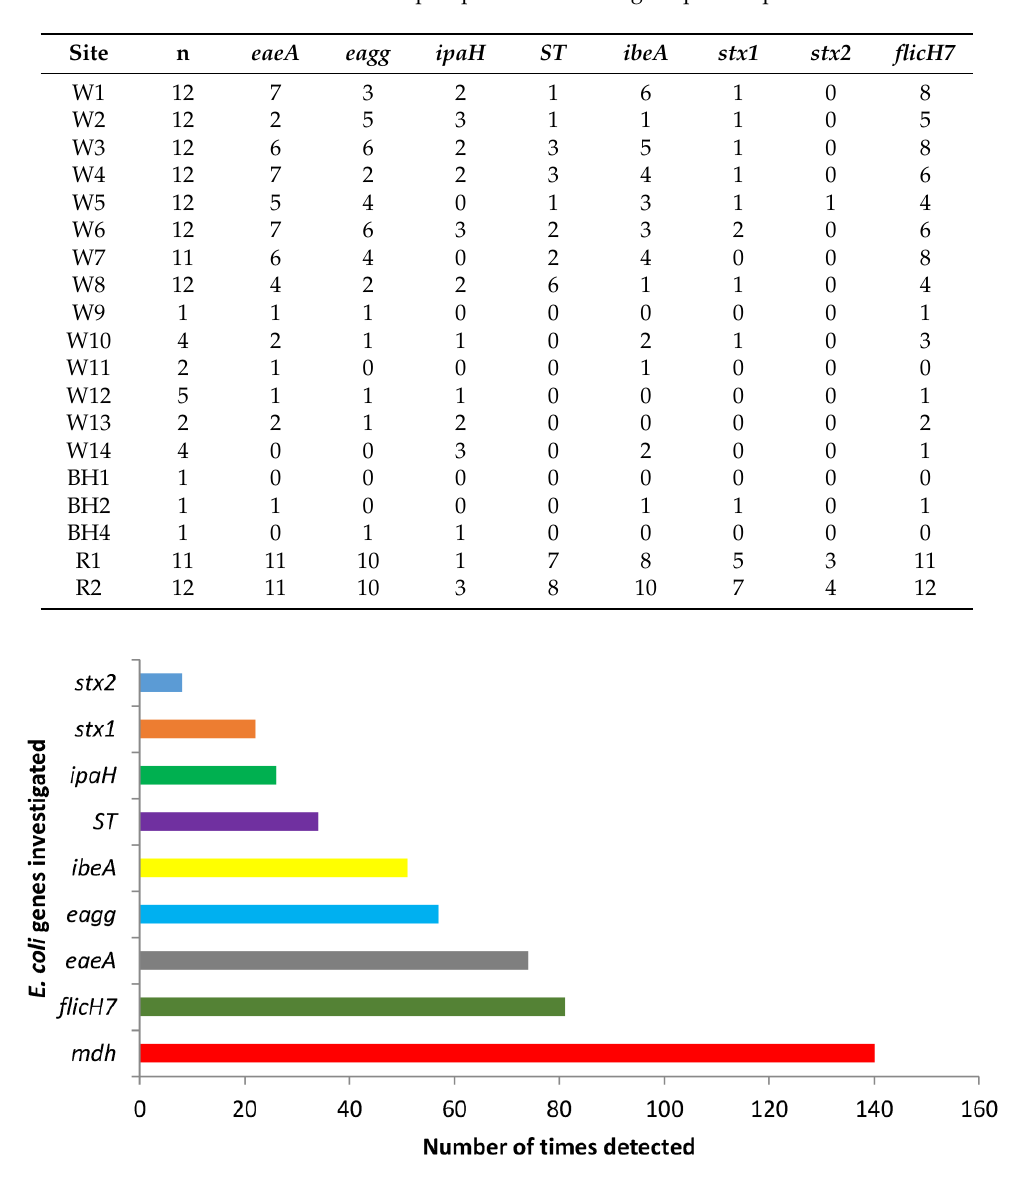
Figure 2. Overall prevalence of the various E. coli virulence genes detected during the entire study